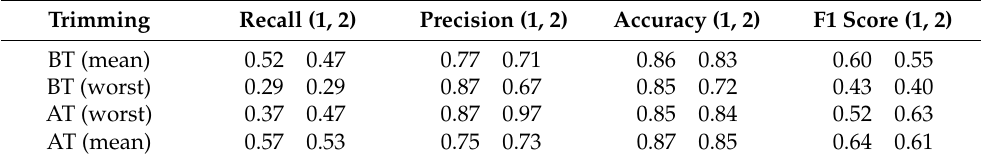
Table 4. Four performance results of RNN with training data type [Genre*ATV]. (In parentheses of the performance metrics, 1 means data set (1) and 2 means data set (2)).